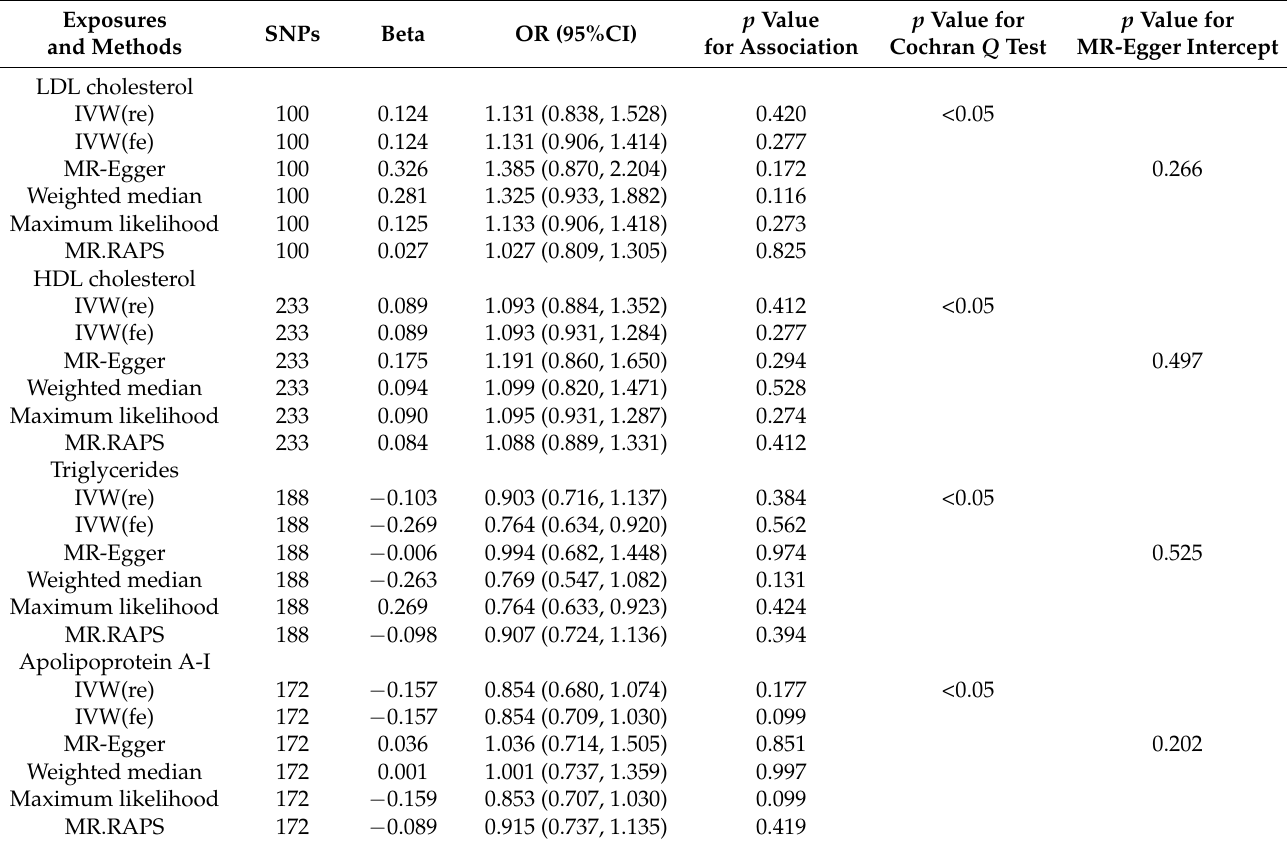
Table 1. Two-sample Mendelian randomization of blood lipids levels and the risk of